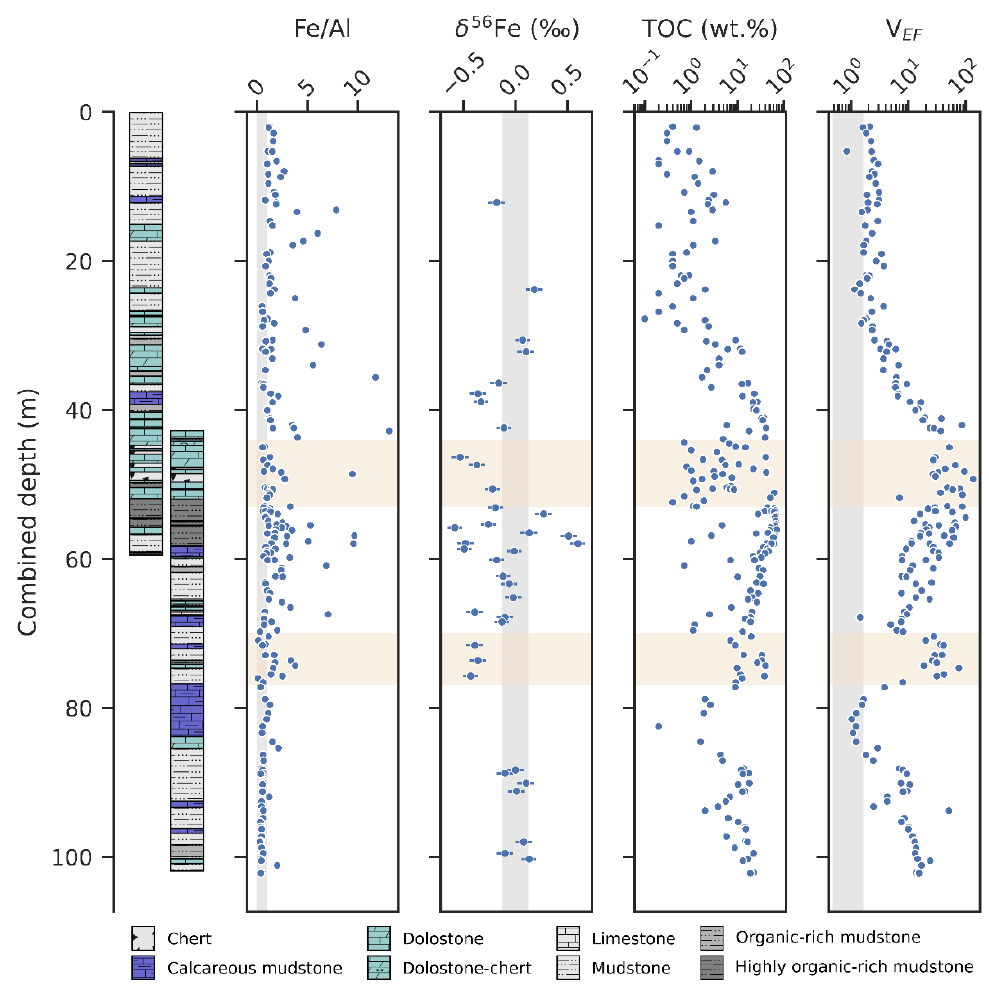
Figure 2. Geochemical indicators of Fe redox cycling in the OnZaP drill cores—authigenic Fe excess (Fe/Al) and Fe isotope composition ( δ 56 Fe)—with other redox indicators: Total organic carbon (TOC) and the vanadium enrichment factor (V EF ). Grey vertical spans denote average crustal composition [35,96], yellow horizontal spans denote zones of secondary silicification [15]. Note the logarithmic scales on the TOC and V EF axes.